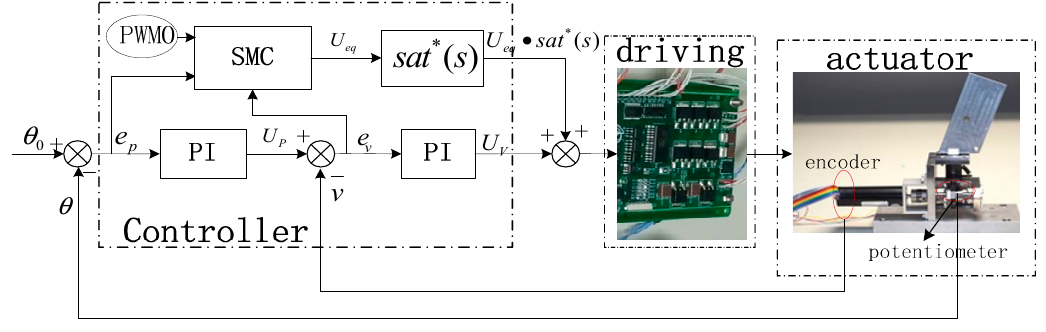
Figure 5. The controller of EMA system.